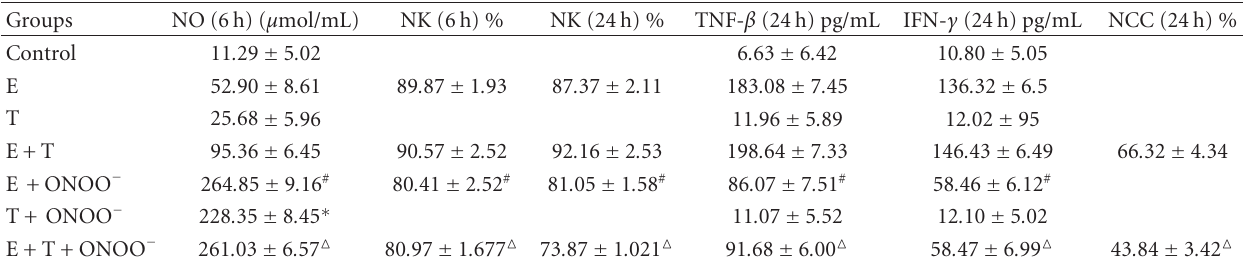
Table 1: The e ff ect of ONOO − on the activity of NK